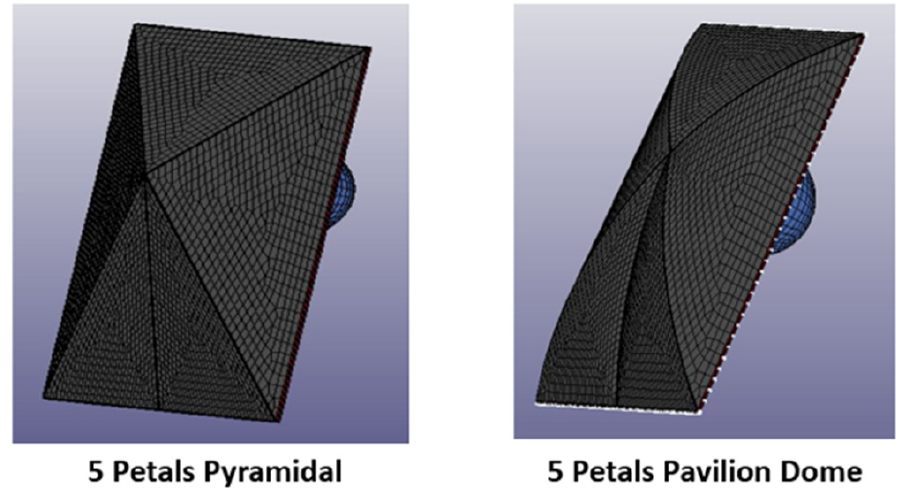
Figure 14. Pyramidal and Pavilion Dome Tailgate Configuration.